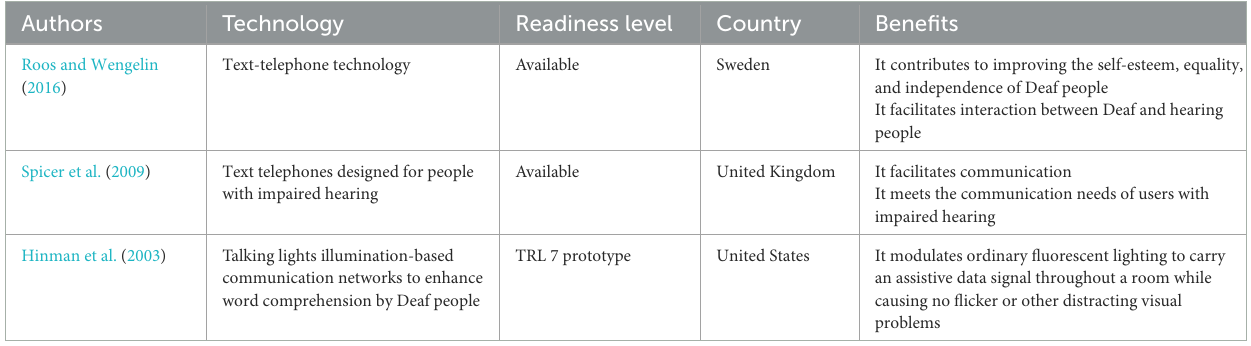
TABLE 6 Technologies based on text and illumination